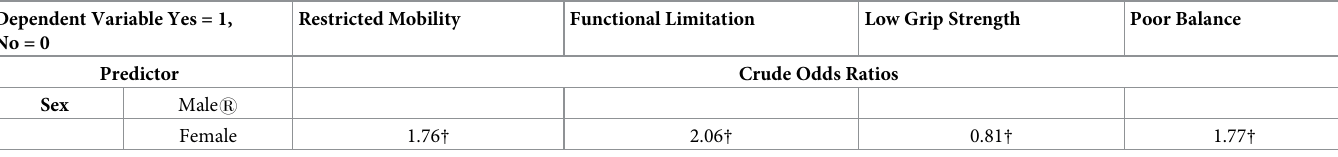
Table 5. Unadjusted association between gender and poor health outcomes. Dependent Variable Yes = 1, No =